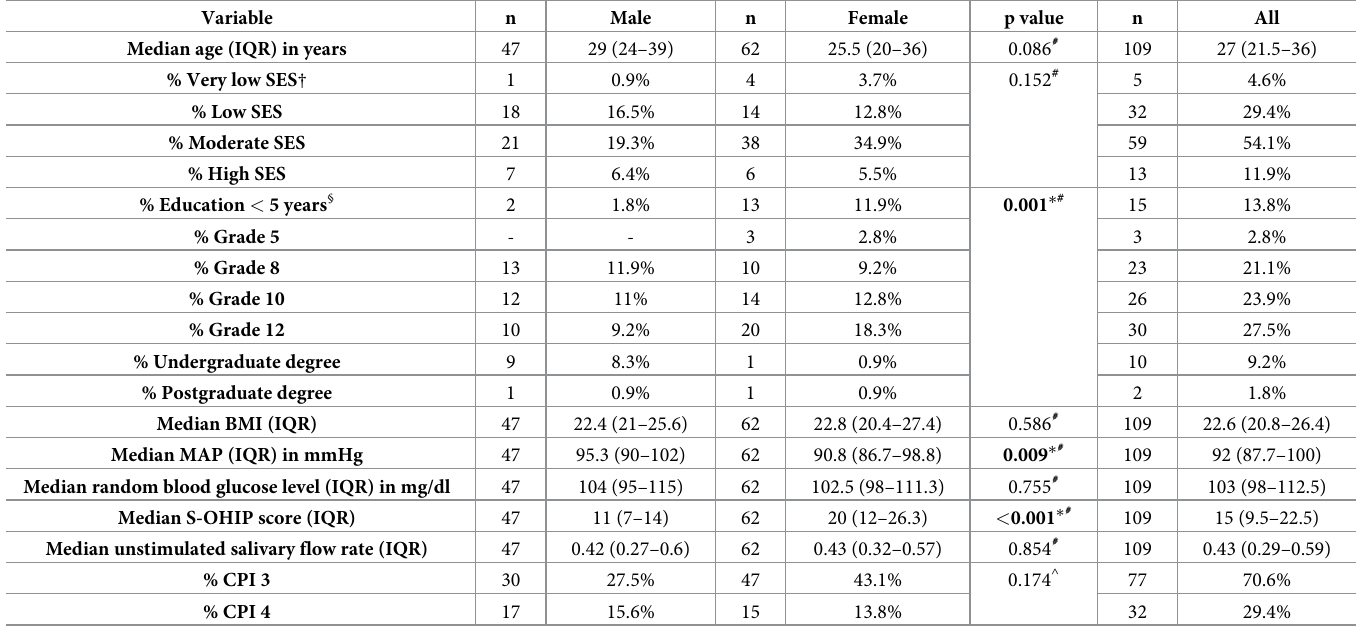
Table 1. Sociodemographic, general health, periodontal status, unstimulated salivary flow rate, and S-OHIP scores of patients with periodontal disease.